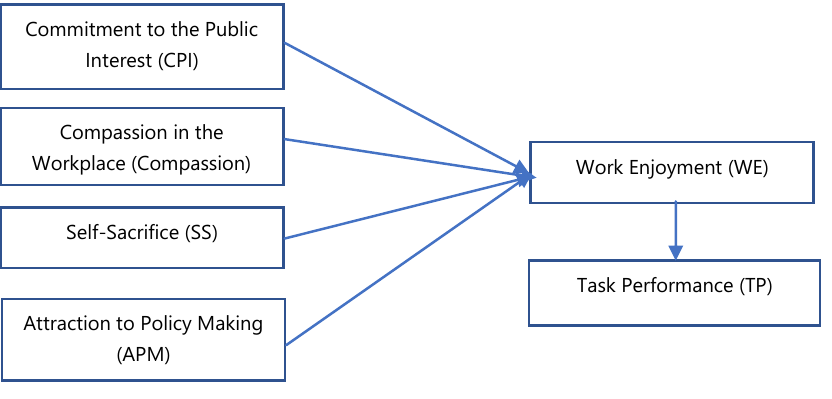
Figure 1: The Research Model (Source: Authors’